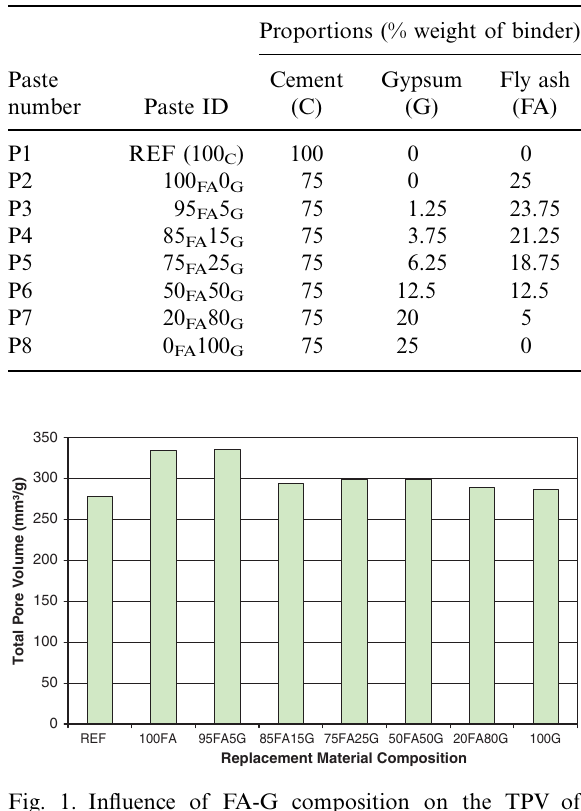
Table 2. Constituents of binder